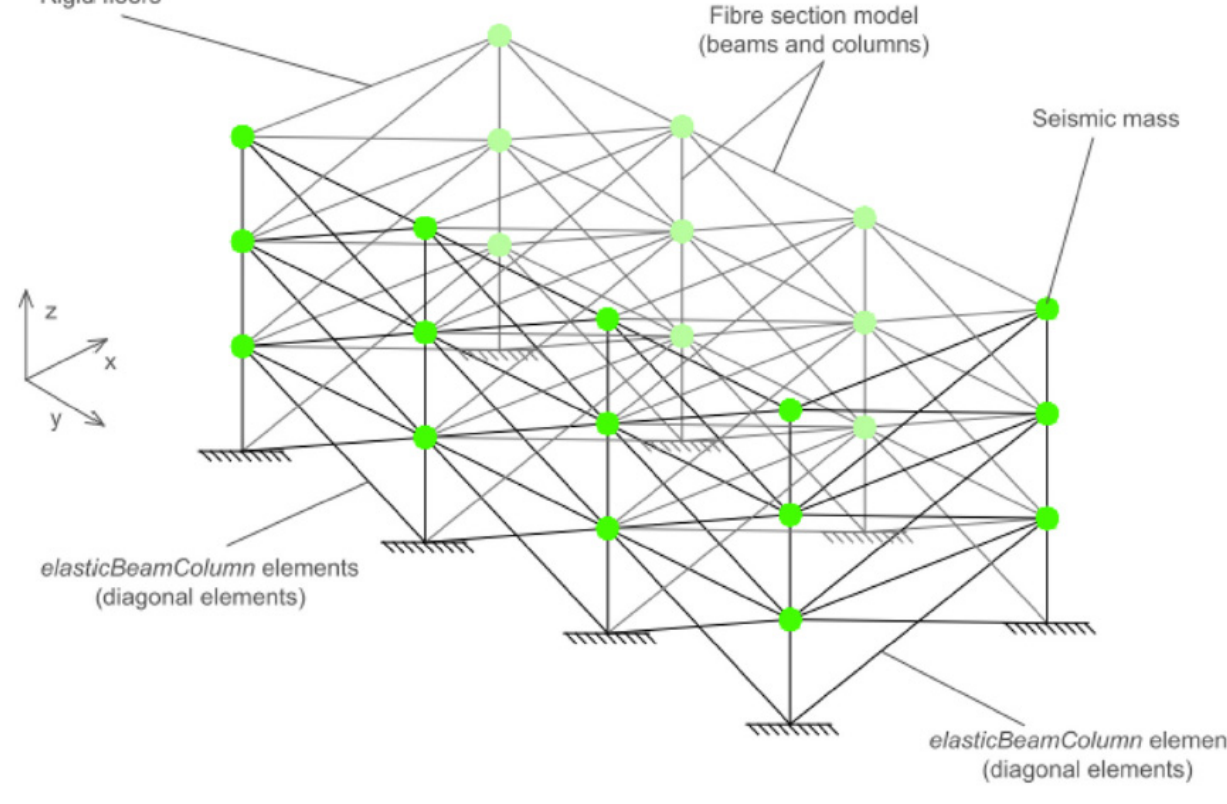
Figure 2. Structural 3D model .